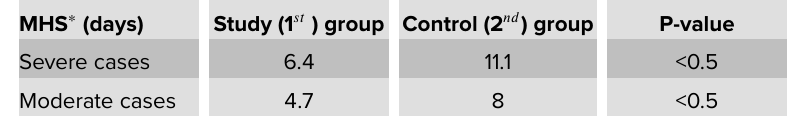
TABLE 4: The mean hospital stay.